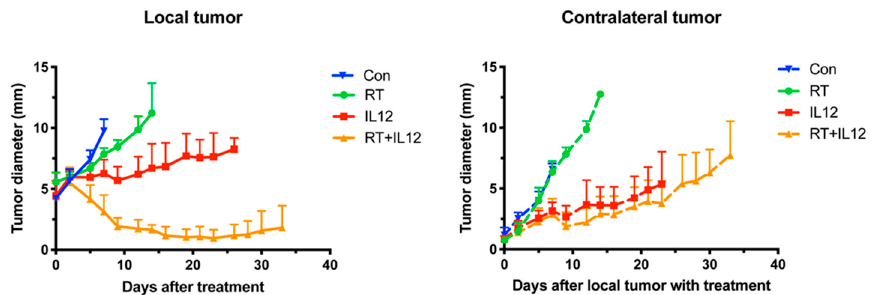
Figure 5. RT did not further improve IL-12-mediated anti-tumor effect on distant tumors. An equal number of TRAMP-C1 tumor cells were implanted in the right and left legs, respectively, of mice at 4-day intervals. The tumors of right legs were treated with irradiation and/or IL-12 therapy when tumor grew up about 4 mm. The growth of local and contralateral tumors was measured every 2 days with at least three mice in each time point.